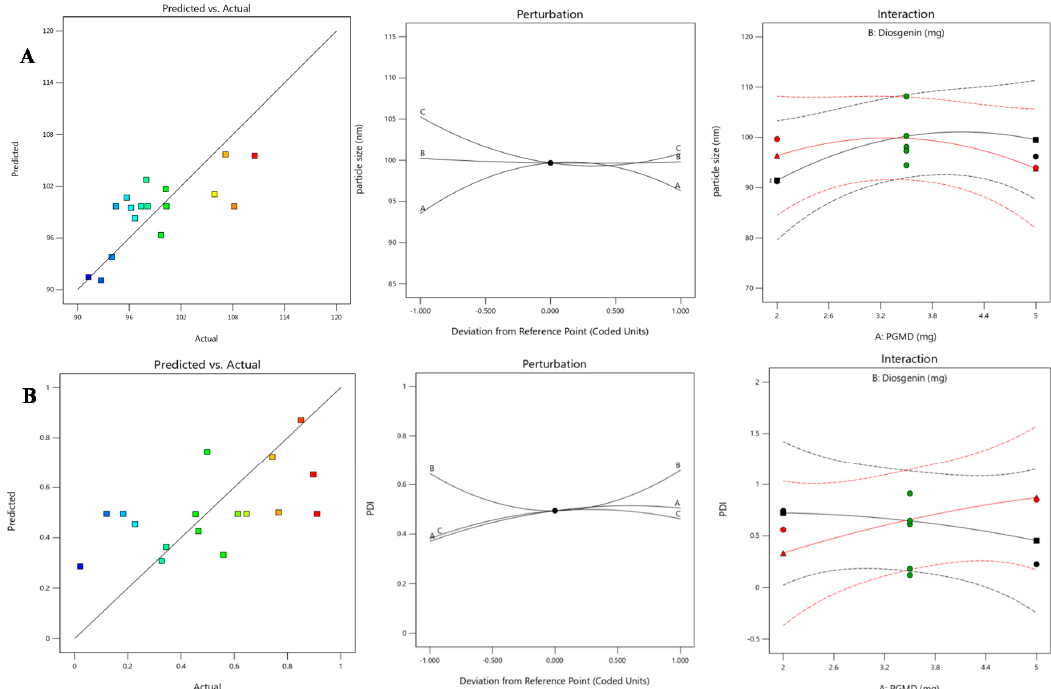
Figure 1. Model diagnostic plots showing predicted vs. actual, perturbation and interaction plots for response variables- ( A ) particle size and ( B ) PDI.